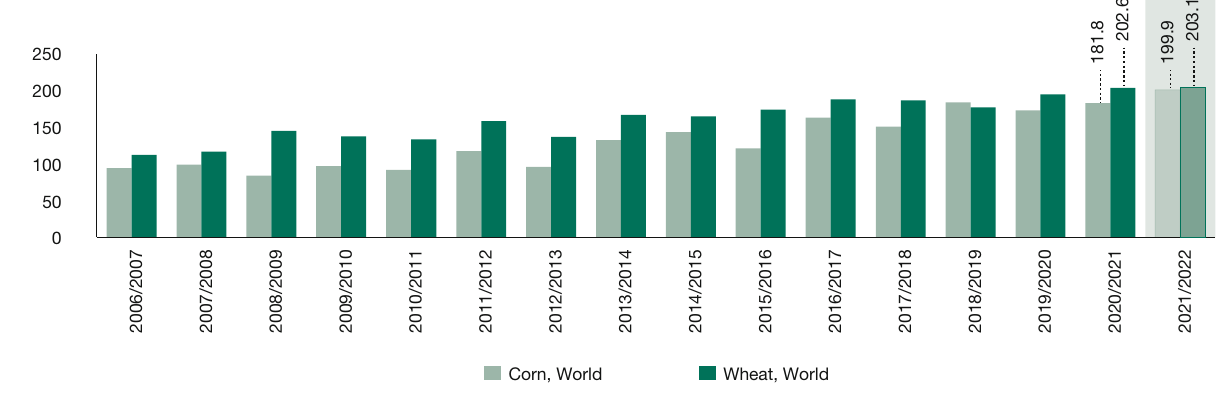
Figure 5 Global wheat and corn exports: Observed (2006/07-2020 /21) and forecast (2021/22) in million